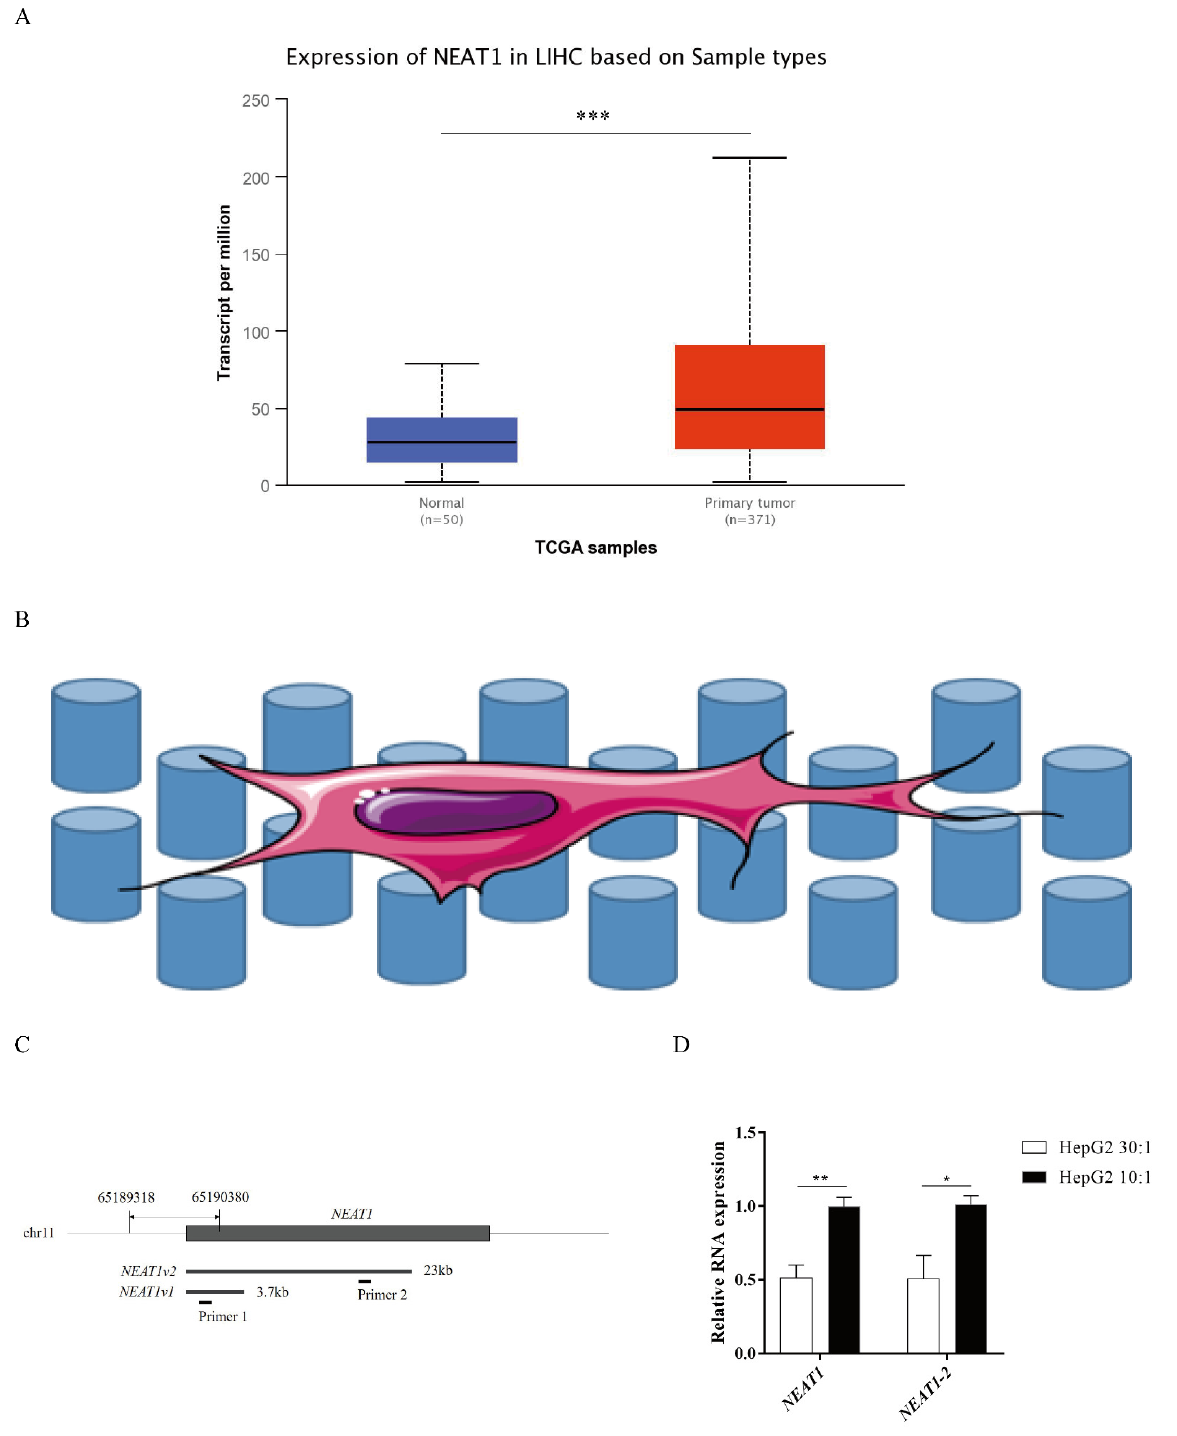
Figure 1. Higher substrate stiffness enhances NEAT1 expression in HepG2 cells. ( A ) Analysis of expression of NEAT1 in human LIHC samples compared to normal liver samples based on the TCGA using the UALCAN databases. ( B ) The model of 3D topological micropillars. The establishment of two different substrate stiffness using PDMS, and then HepG2 cells were cultured on it. ( C ) The primers of NEAT1 and NEAT1v2 to detect total NEAT1 and NEAT1v2 , respectively. ( D ) HepG2 cells are cultured on the 3D micropillars (10:1, 30:1) for 48 h. Analysis of NEAT1 expression by qPCR. * p < 0.05, ** p < 0.01, and *** p